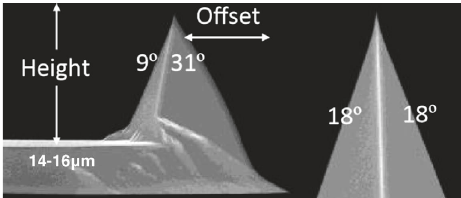
Figure 3: This figure, provided by AppNano, shows the dimensions of the tetrahedral